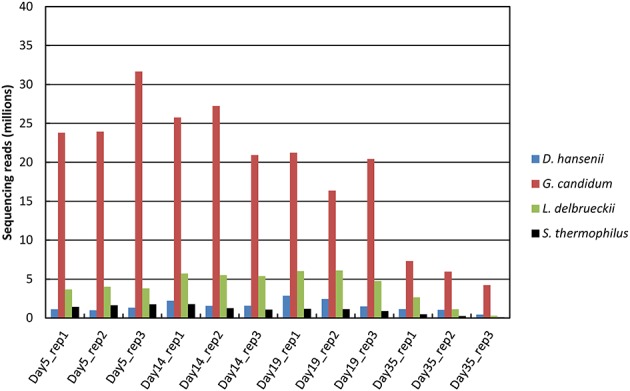
Distribution of the sequencing reads that mapped to CDSs as a function of the reference genome. Only reads that mapped to unique sequences of the database were considered. Brevibacterium aurantiacum reads were not represented because their number was very low (from 2000 to 27,000 reads, depending on the sample).